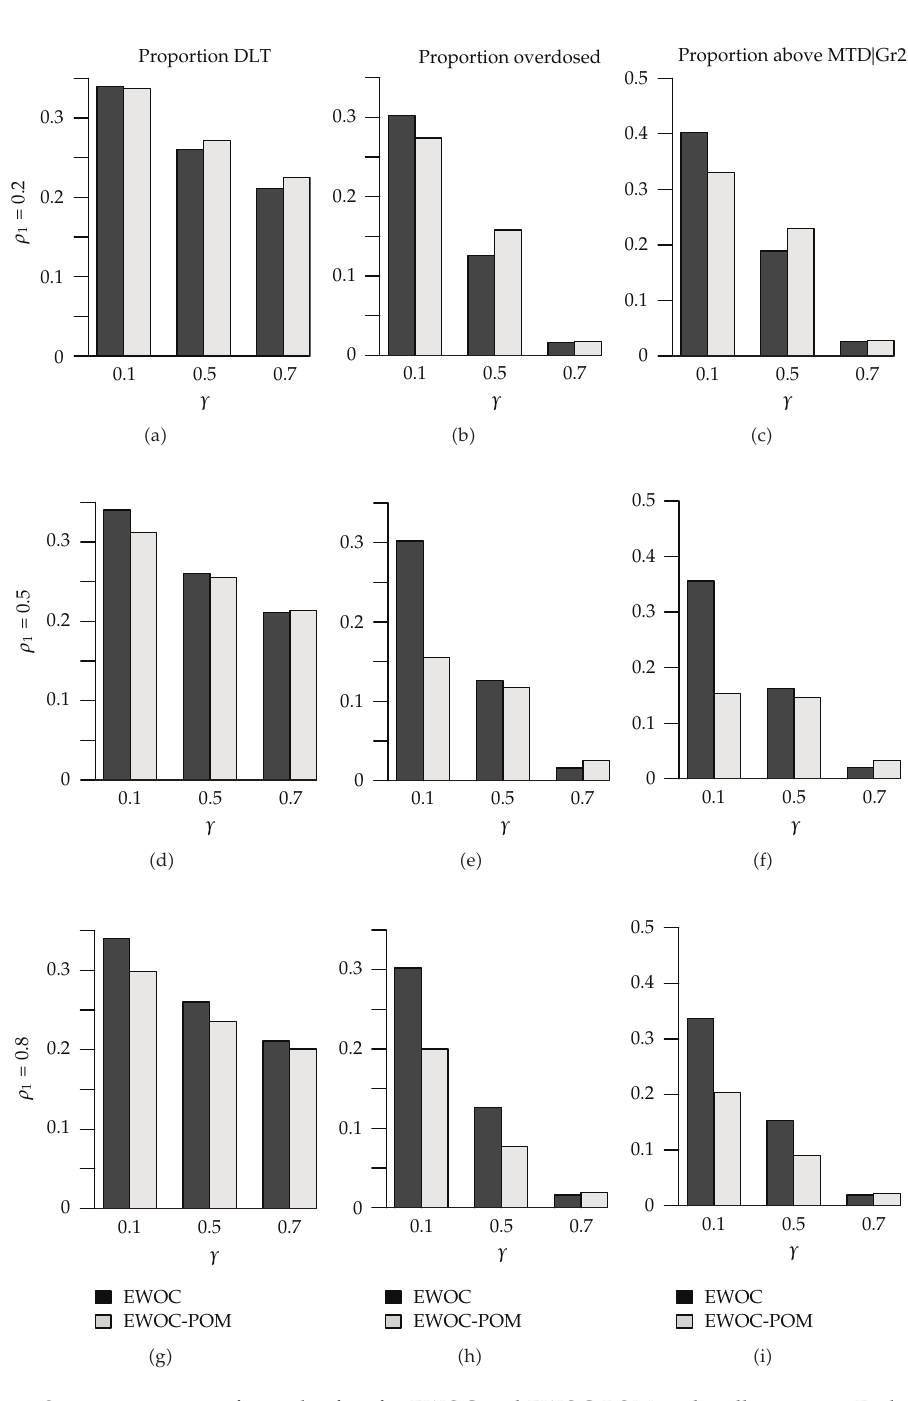
Figure 3: Summary statistics for trial safety for EWOC and EWOC-POM under all scenarios. Each graph represents mean proportion obtained from all patients from all 1000 simulated